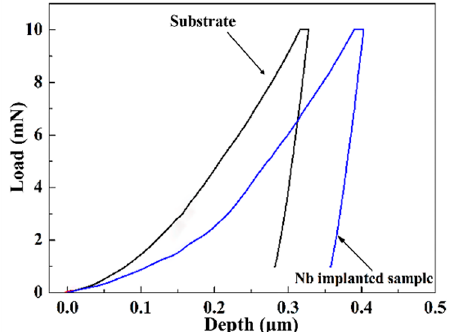
Figure 3. The nanoindentation Load–Displacement curves of the substrate and the Nb-implanted sample. Table 1. Calculated values of elastic modulus and hardness of samples.